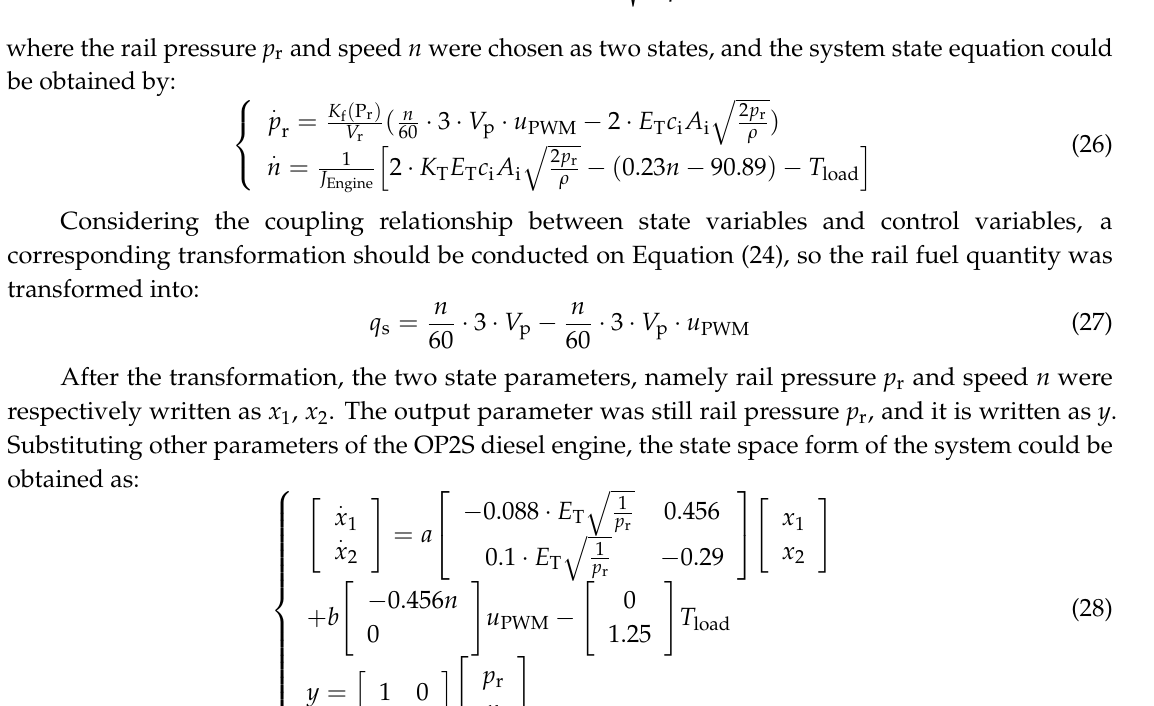
algorithm based on state space and the PID control algorithm optimized by optimal control are introduced as